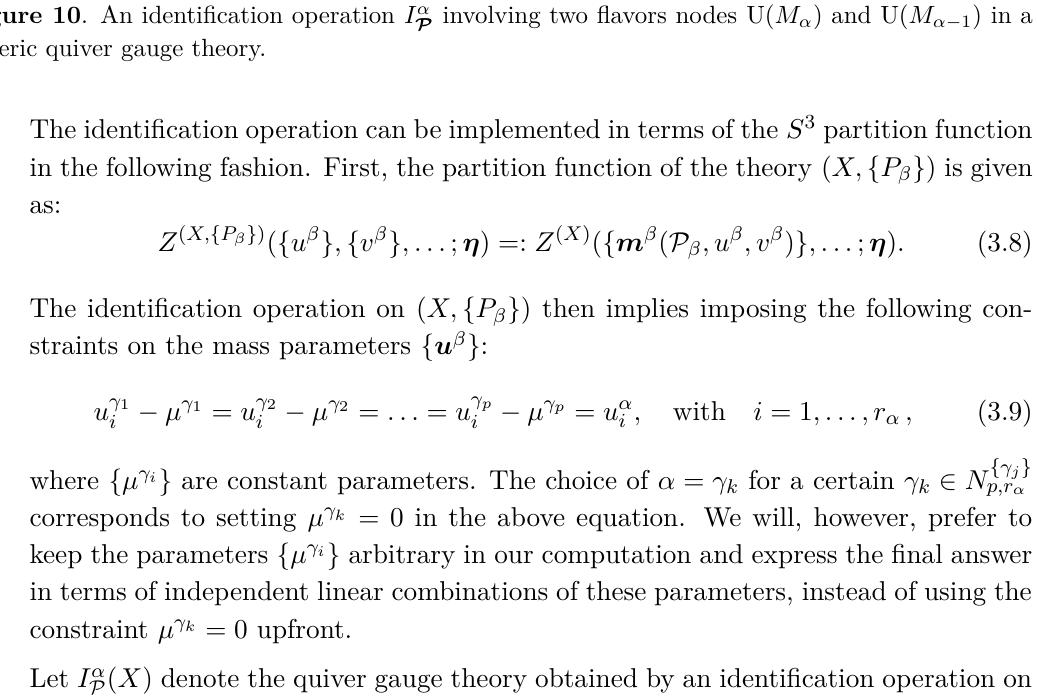
) and U( M ) in a α α − 1